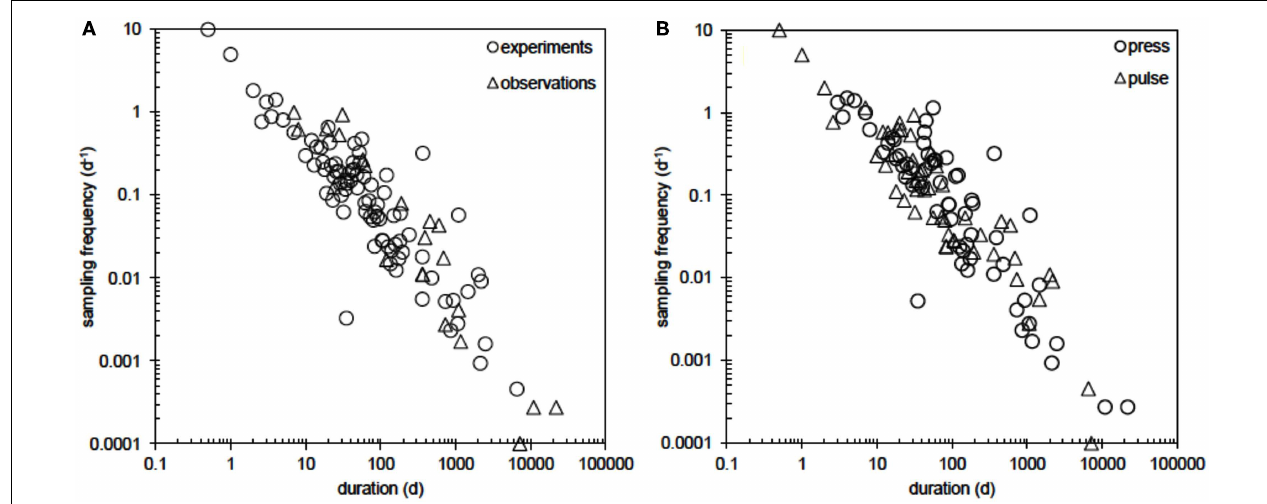
no pronounced bias toward short-term studies with a high sampling frequency in pulse disturbance studies (B) . However, the relationship between study duration and sampling frequency (A,B) indicates logistic and/or conceptual constraints, which may limit our ability to predict microbial community responses to disturbance. “d” is